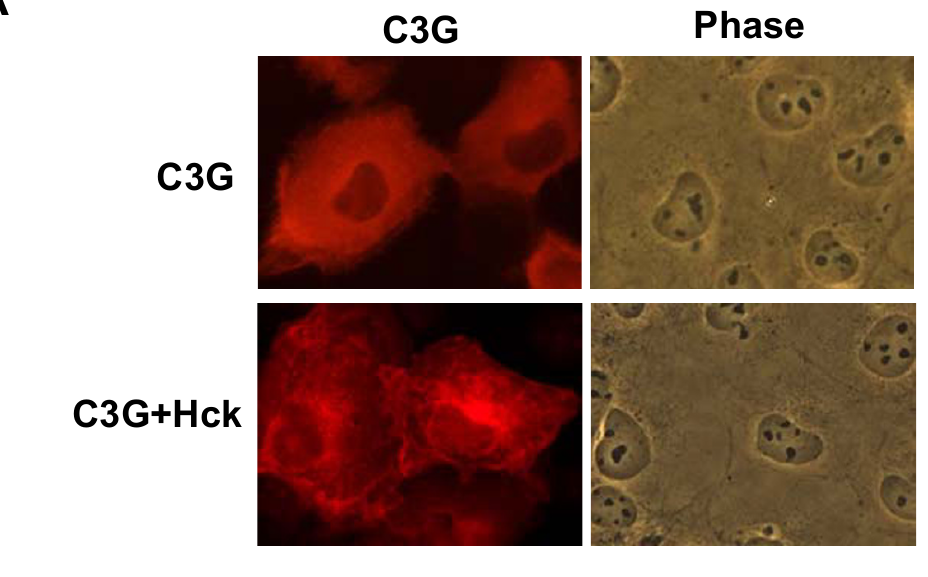
number of cellular polypeptides are phosphorylated on tyrosine upon Hck expression, (Fig. 2A, right panel) but